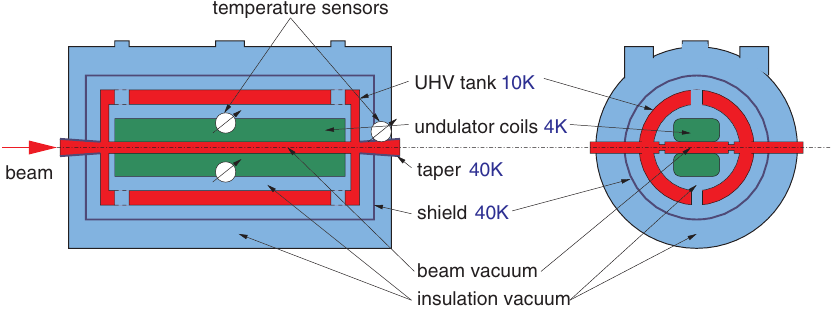
GENERATION OF X-RAY RADIATION IN A STORAGE . .